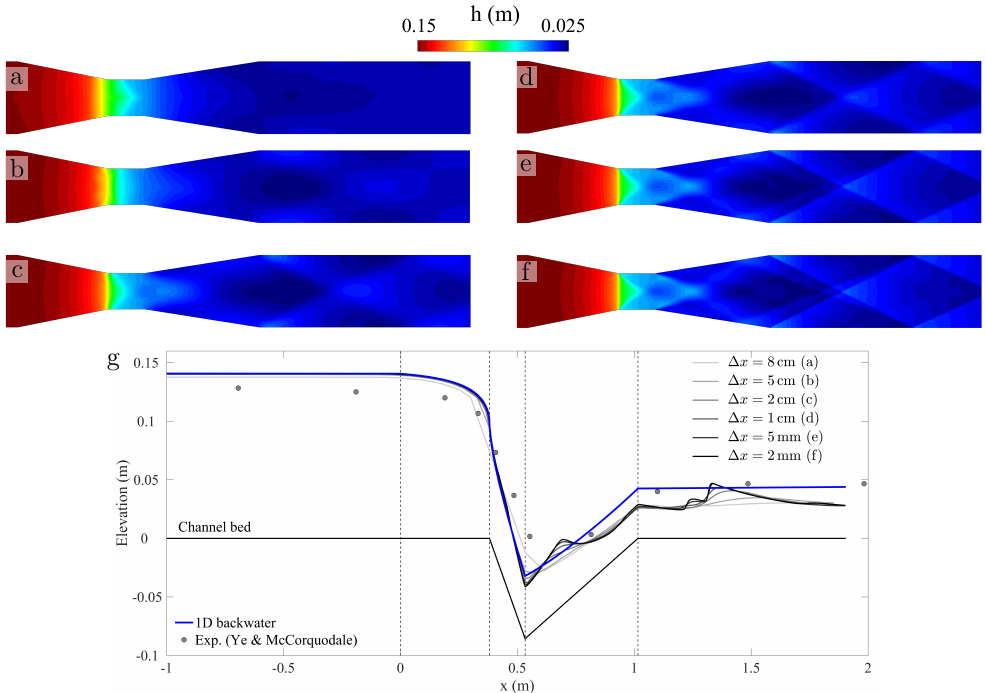
Figure 8. Impact of grid refinement on the comparison between the 2D shallow water equations and experimental observations of flow past a Parshall flume. We show the maps of water depth (panels a – f ) and a comparison between water depth profiles along the axis of the flume (panel g ) for several grid sizes, ∆ x